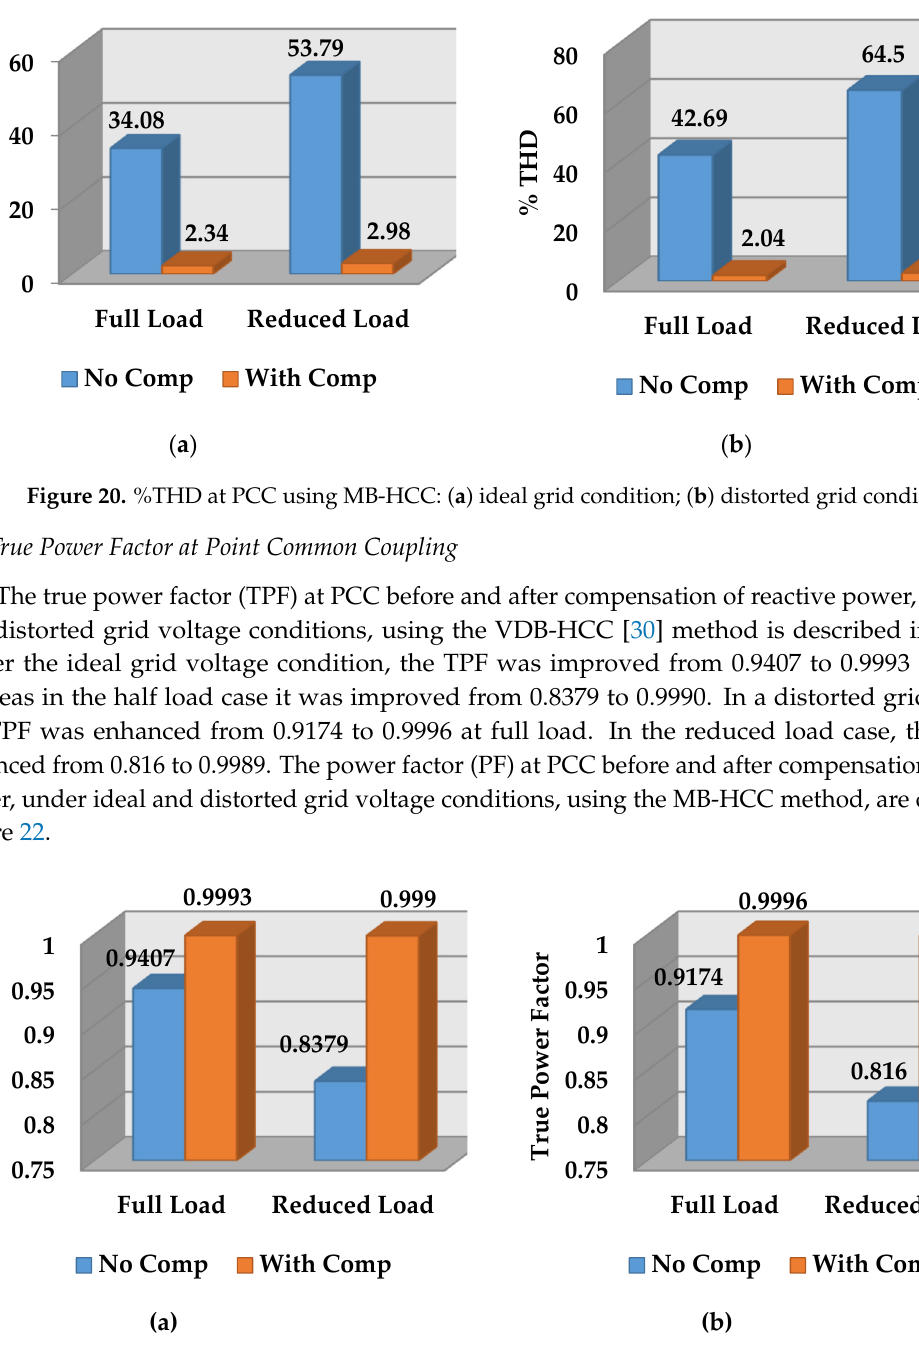
Figure 21. True power factor at PCC using VDB-HCC: ( a ) ideal grid condition; ( b ) distorted grid condition.